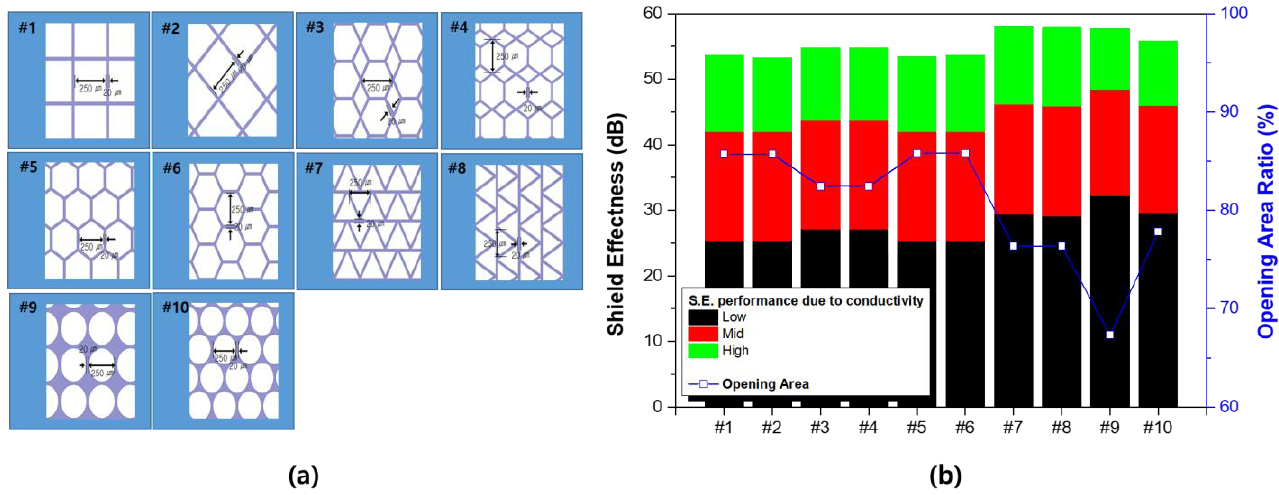
Figure 4. Evaluation of the aperture ratio and shield effectiveness according to pattern design. ( a ) Pattern idea derived from the standard of 20 µ m line width and 250 µ m diameter of the opening area. ( b ) Light transmittance and shielding performance simulation result for each pattern (conductivity condition—low: 6.1 × 10 4 , mid: 6.1 × 10 5 , and high: 6.1 × 10 7 , Unit: S/m).